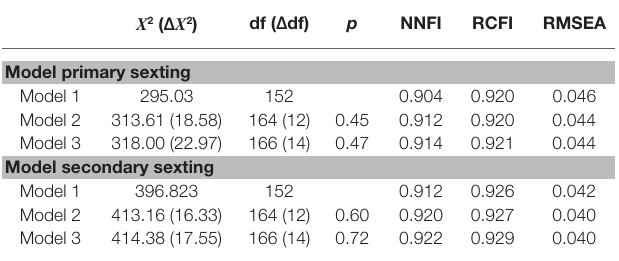
Model 1: Configural invariance. Model 2: Measurement invariance (equal factor loadings). Model 3: Structural model invariance (equal factor loadings, factor variances, and covariances). Χ 2 , Chi square statistic; df, degrees of freedom; NNFI, non-normed fit index; RCFI, robust comparative fit index; RMSEA, root mean-square error approximation.